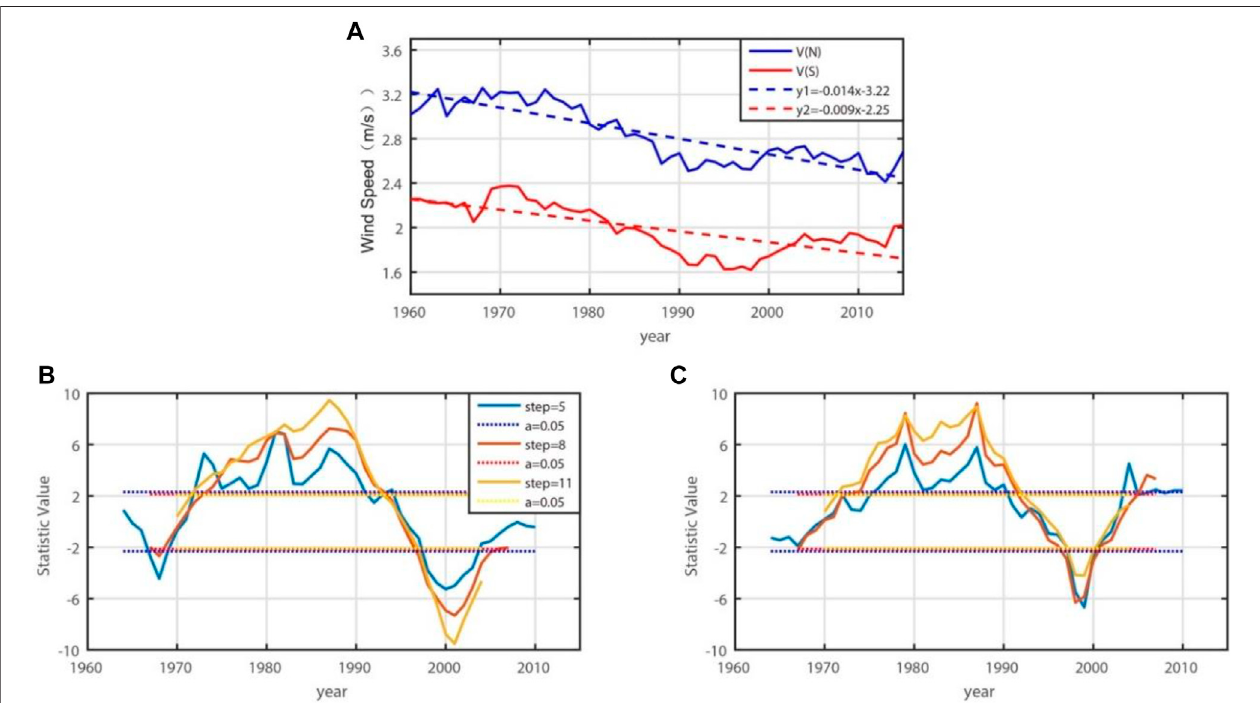
FIGURE 7 | (A) Variations of average wind speed and sliding t -test for (B) Southern Xinjiang and (C) Northern Xinjiang.